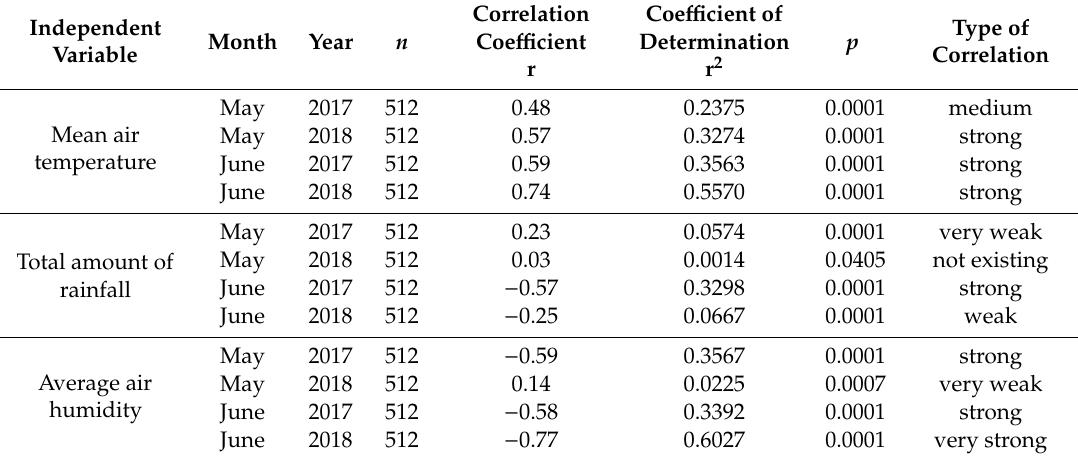
Table 6. The correlation coe ffi cients and coe ffi cients of determination for ECB infestation expressed as a % of the attack of first generation as a dependent variable on di ff erent weather conditions (the mean air temperature, total amount of rainfall, and average air humidity) as independent variables in two years of